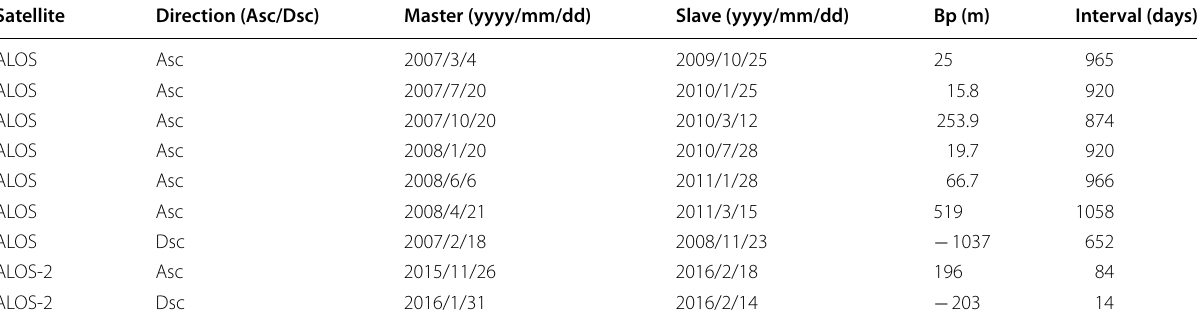
Asc, ascending; Dsc, descending; Bp, perpendicular